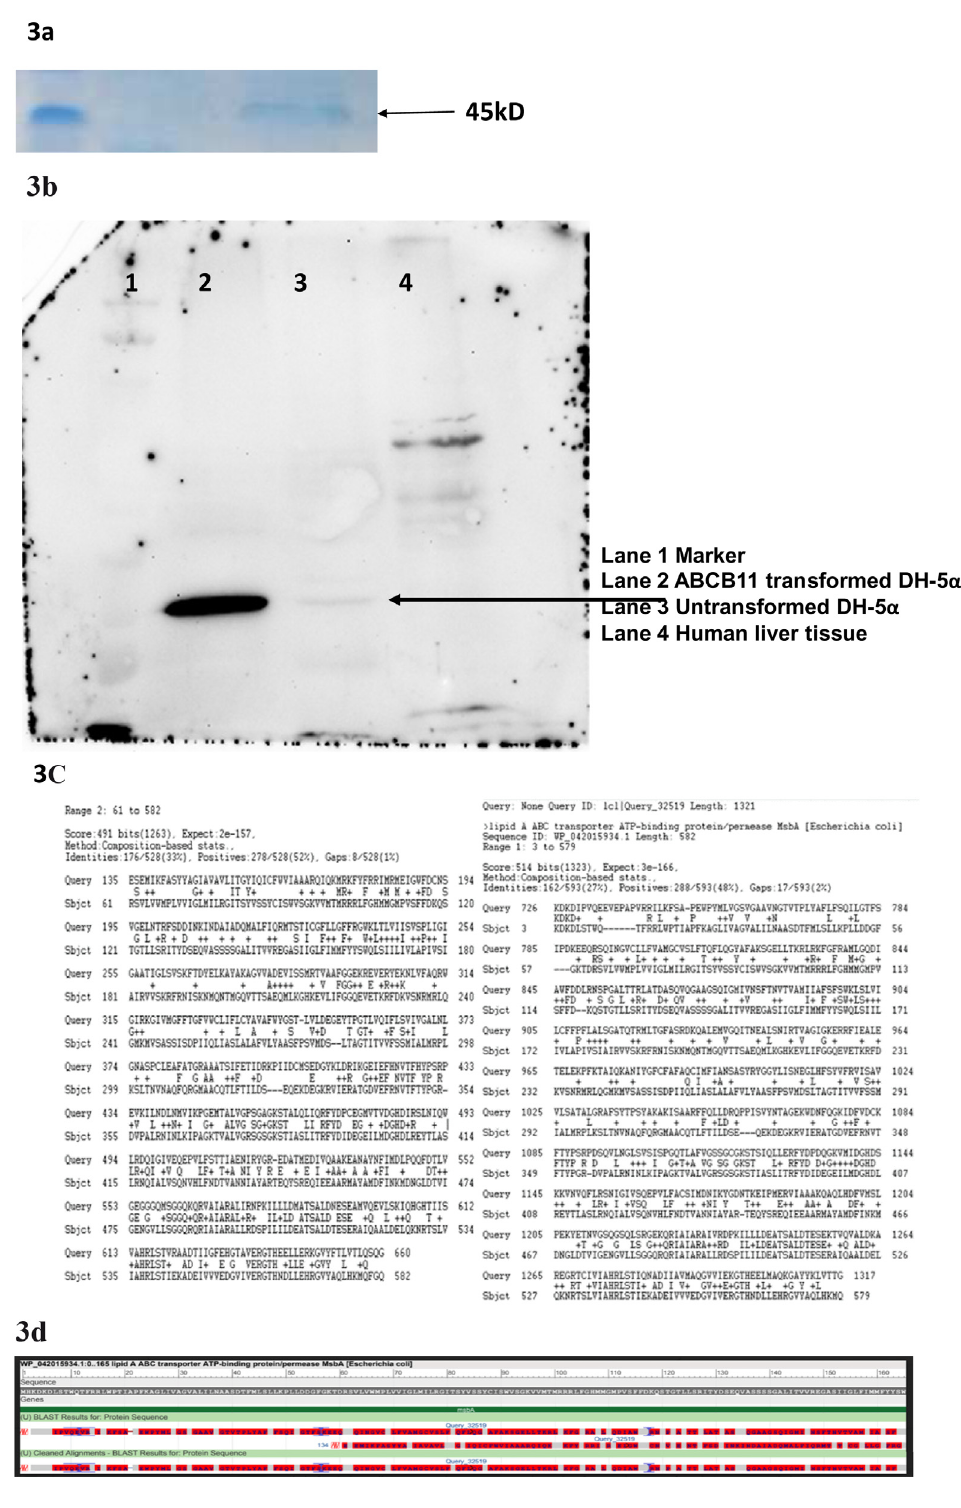
Figure 3. ( a ) Total protein extract from E. coli transformed the donor vector on Poly Acryl amide Gel Electrophoresis followed by Coomassie blue staining showed differential expression multiple proteins. ( b ) Western Blot with anti-human ABCB11 antibody shows multiple bands including one probably corresponding to MsbA- a bacterial Lipid A transporter. ( c ) A bioinformatic analysis (Protein BLAST) revealed ABCB11 and MsbA are sharing conserved domains. ( d ) Sequence alignment of ABCB11 and MsbA showing conserved